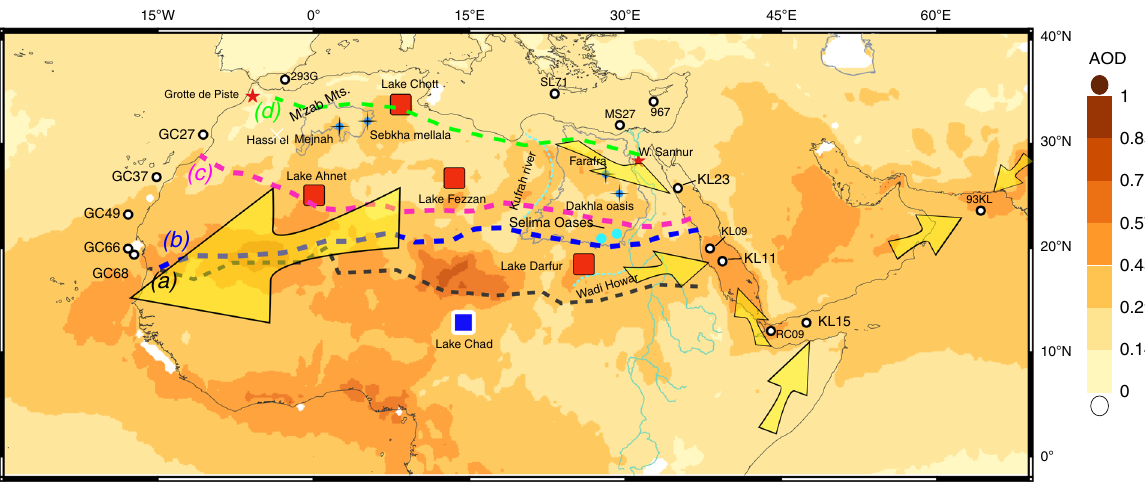
Fig. 3 Climatic records of the African Humid Period (AHP). 230 Th xs -normalized dust accumulation rates in cores KL23, KL11, and KL15 from the Red Sea and Gulf of Aden. Dust accumulation rates and other properties from: the Atlantic Ocean GC27, GC37, GC49, GC66, and GC68 reported by McGee et al. 21 ; Red Sea core KL09 36 ; Arabian Sea RC09 25 and 93KL 37 ; Mediterranean Sea 293G 17 , SL71 16 , MS27 27 , and core 967 18 . Yellow arrows indicate the primary dust routes from land to the studied sites as computed from air mass back trajectories. Red stars locate the speleothem caves of Grotte de Piste 39 , and Wadi Sannur 29 , red squares indicate the approximate location of rejected mega lakes, and a blue square indicates the approximate location of mega lake Chad 10 . The bold dashed lines show various precipitation borders, note the letters on their left end: black a modern 50 mm/yr isohyat 60 , blue b AHP modeled increase of precipitation by 50 mm/yr from PMIP3 10 , purple c northern most reach of African monsoon precipitation as proposed here, and green d the approximate northern extent of evidence supporting wetter conditions during the AHP. The green line was drawn based on previous compilations from: lacustrine and palustrine deposits 8,15 , vegetation based modeling 34 , leaf wax data 7 , mineralogical studies in the Mediterranean 16 and the suggested mega lakes 10 . Dust records from the northern Red Sea 30 indicate negligible environmental perturbations in this region during the AHP. Collectively, these observations indicate that monsoonal precipitation and the environmental change it drives (i.e., increased soil humidity, vegetation cover and dust retention) did not reach the latitudes from where dust originated to the northern Red Sea north of ~ 25°N. However, we draw the purple line even further